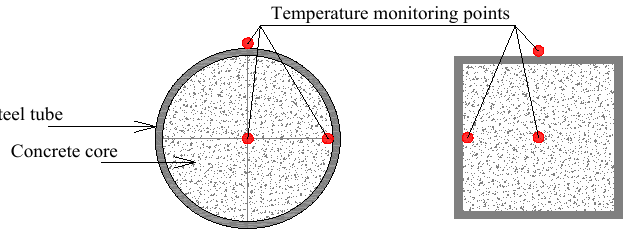
Figure 19. Monitoring points in the cross section.